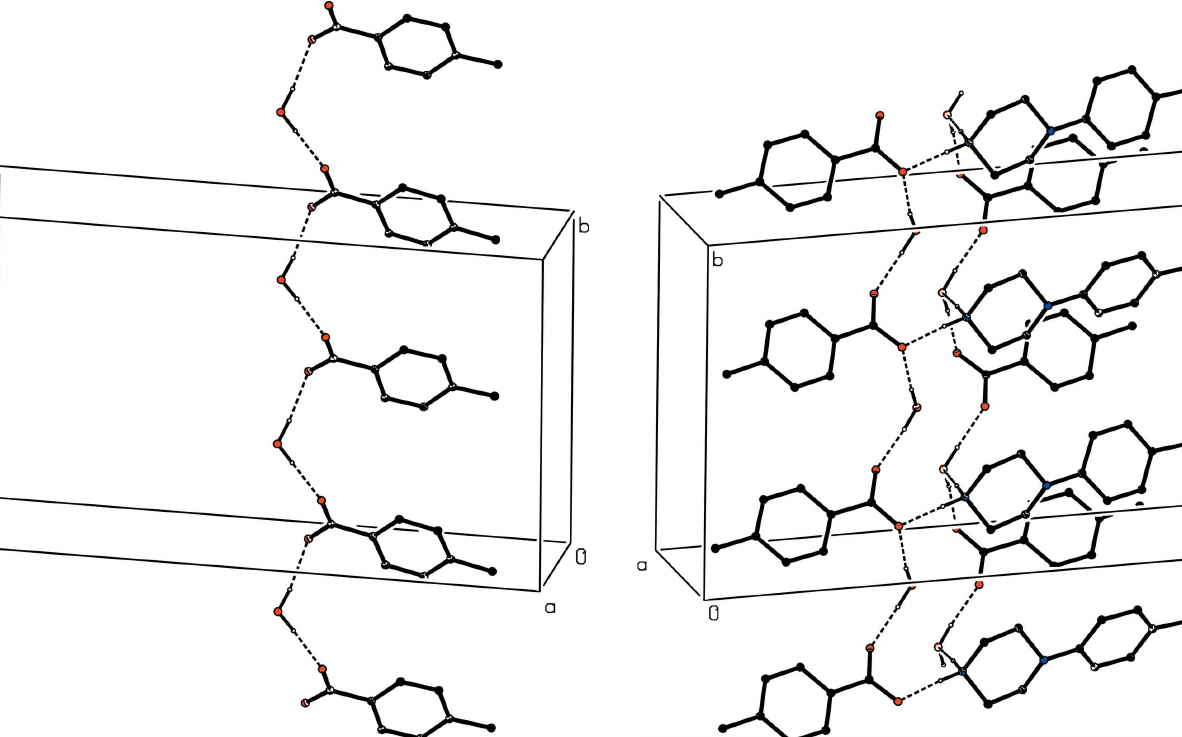
Figure 4 Part of the crystal structure of compound (I) showing the formation of a C 4 (12) chain of two types of anion and two types of water molecule 4 running parallel to [010]. Hydrogen bonds are drawn as dashed lines and, for the sake of clarity, the cations and the H atoms bonded to C atoms in the anions have been omitted.